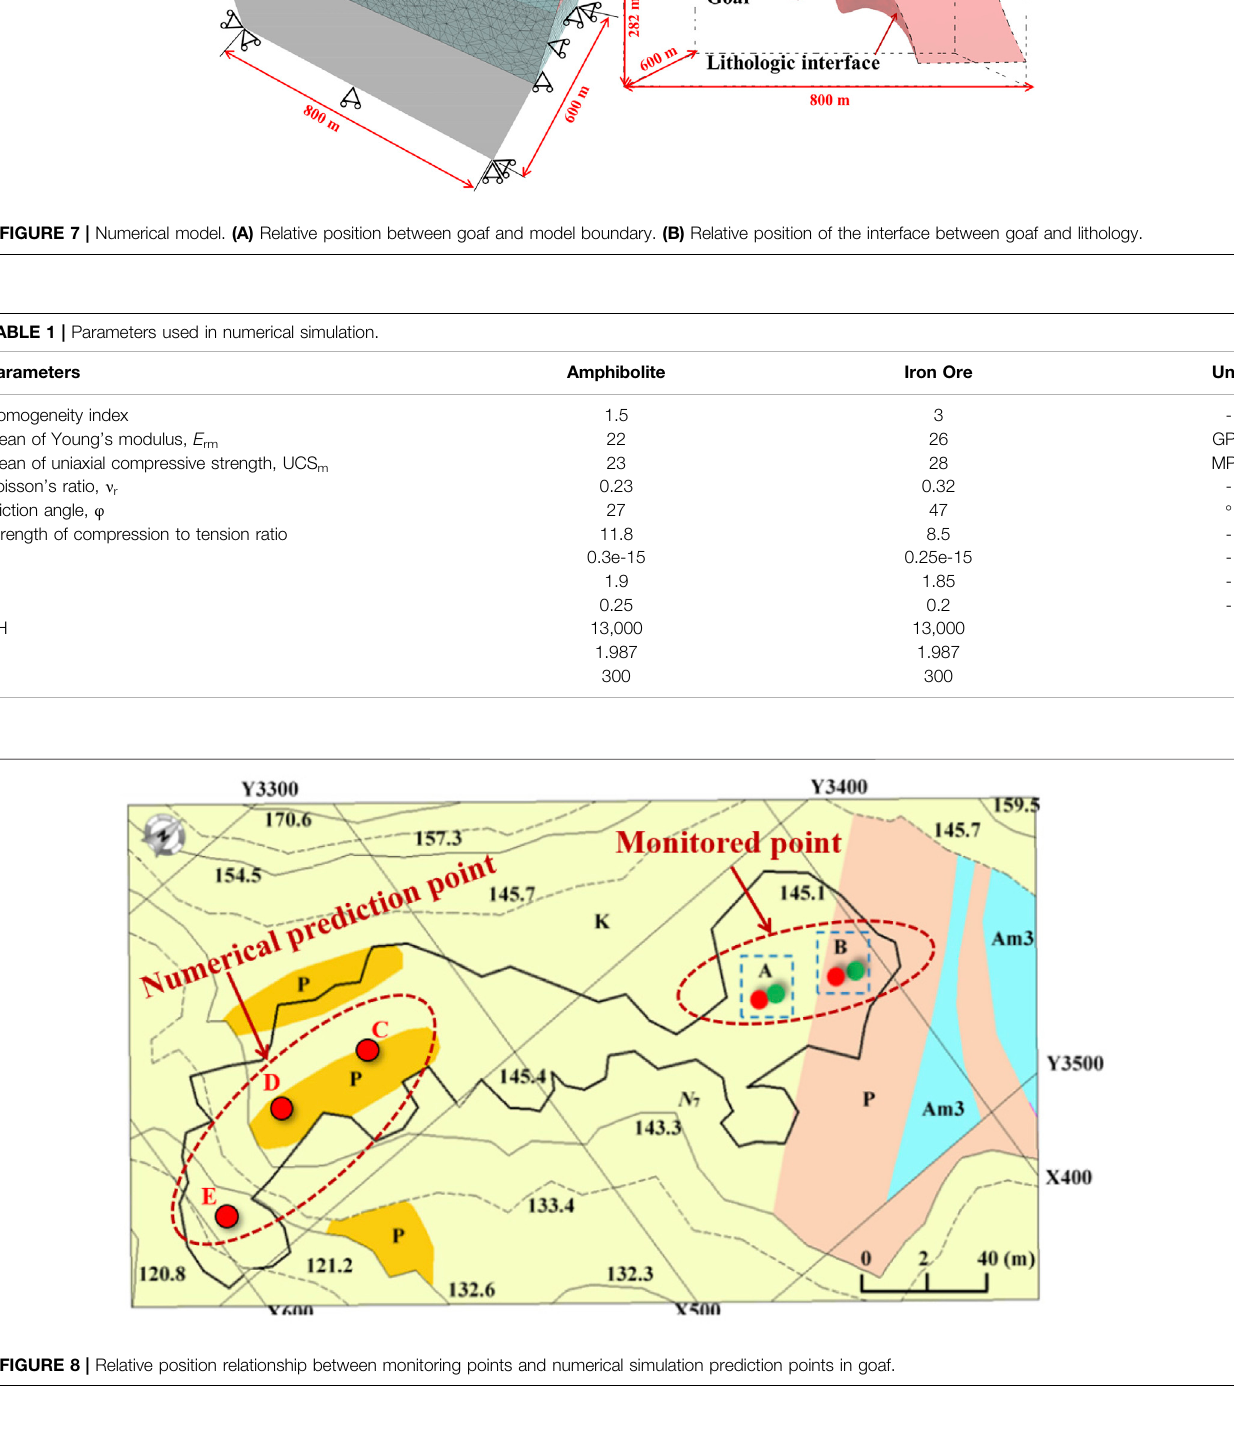
Frontiers in Earth Science |